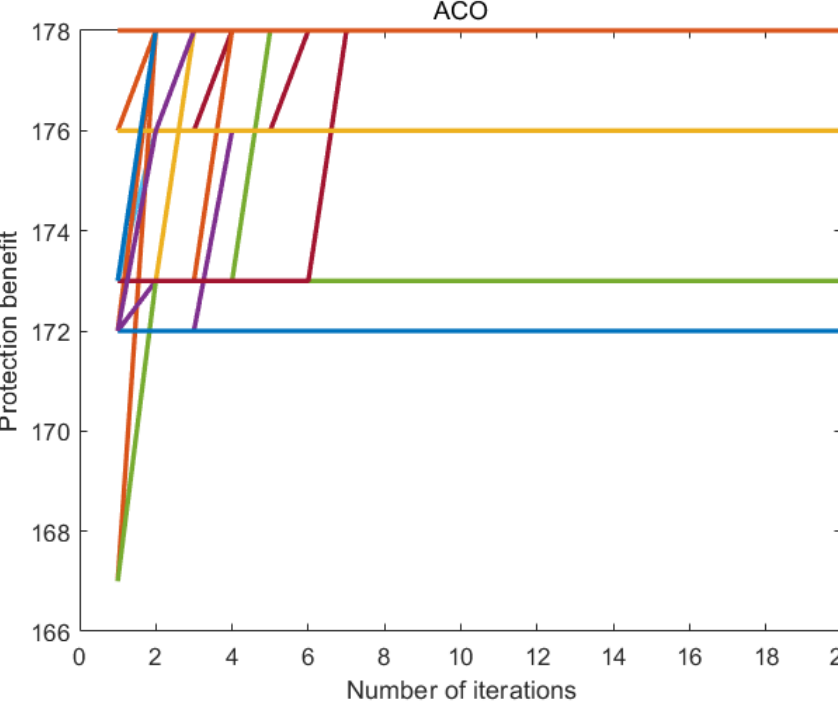
Figure 10. Population size is 100, and the ACO algorithm is run 100